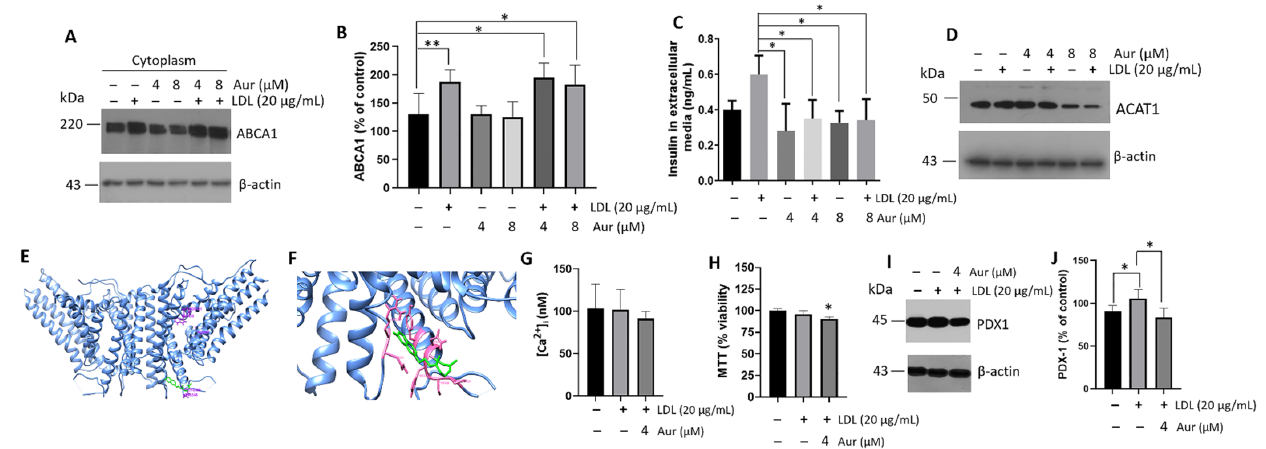
Figure 7. Auraptene (Aur) treatment modulates insulin secretion through intracellular cholesterol metabolism in β -cells. ( A ) Characterization of ABCA1 under LDL (20 µ g/mL) and concomitant treatment with Aur (4 and 8 µ M) at 20 h, control treatments were performed with Aur. ( B ) Densitometry analysis of ABCA1, results are reported as mean ± SD ( n = 3) and expressed as % of control, * p < 0.05, ** p < 0.005. ( C ) Effect of LDL (20 µg/mL) and Aur treatment (0–8 µM) on insulin secretion in extracellular media ( n = 3, mean ± SD), * p < 0.05 with respect to LDL treatment. ( D ) Under the same conditions, with ACAT1 expression in cellular lysates, β-actin was used as a loading control. DMSO was evaluated as a control. ( E , F ) Representation of the ACAT1 (blue, PDB: 6L47) binding to Aur (green) by molecular docking; the residues (pink) indicate the interactions with Aur. ( G ) Intracellular calcium quantification under LDL (20 µg/mL) and Aur treatment (4 µM) at 20 h of incubation; a statistical significance was not found. Under the same conditions, the cellular viability ( H ) and expression of PDX-1 by Western blot ( I ) were evaluated. ( J ) Densitometry analysis of PDX-1, results are reported as mean ± SD and expressed as % of control ( n = 3), * p < 0.05. In panels ( A , D , I ) β-actin was used as a loading control.